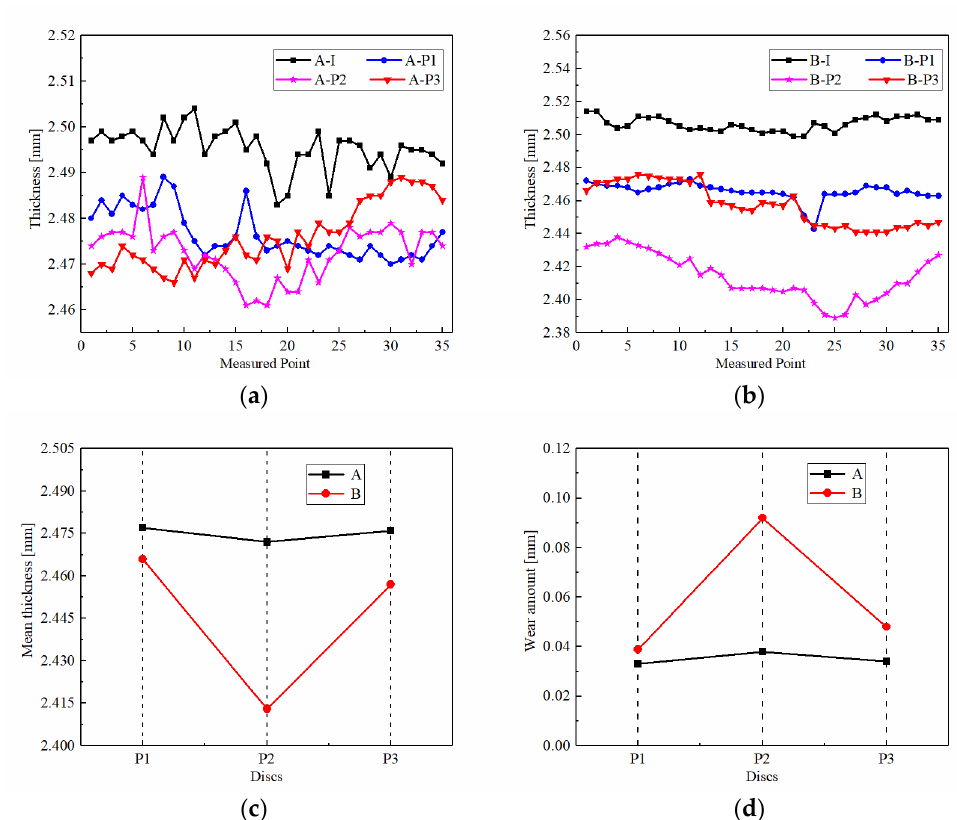
Figure 10. A-I is the pre-test measured thickness of CBFM-A; A-P1, A-P2, and A-P3 are the post-test measured thicknesses ( a ). B-I is the pre-test measured thickness of CBFM-B; B-P1, B-P2, and B-P3 are the post-test measured thicknesses ( b ). The mean thicknesses of discs ( c ) and the wear amounts ( d ). The wear degree of friction discs in different axial positions is quite different as